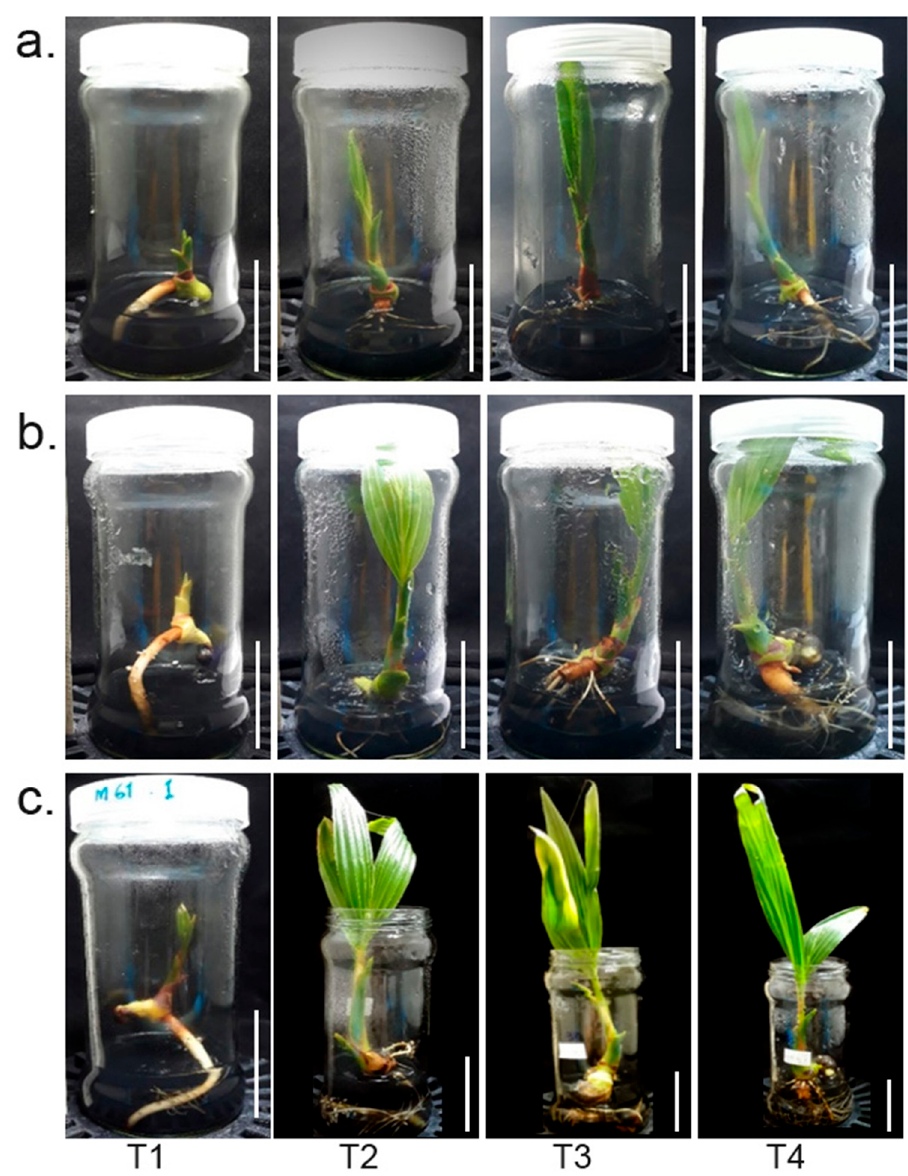
Figure 1. Seedling growth under different root-excision treatments at different timepoints. Embryo cultures of control (intact root: T1) and three root excision treatments, 0.5 cm (T2), 1.0 cm (T3), and 2.0 cm (T4), at three stages: ( a ) 1 month, ( b ) 2 months, and ( c ) 3 months after root excision, respectively. The scale bar represents a length of 5 cm.